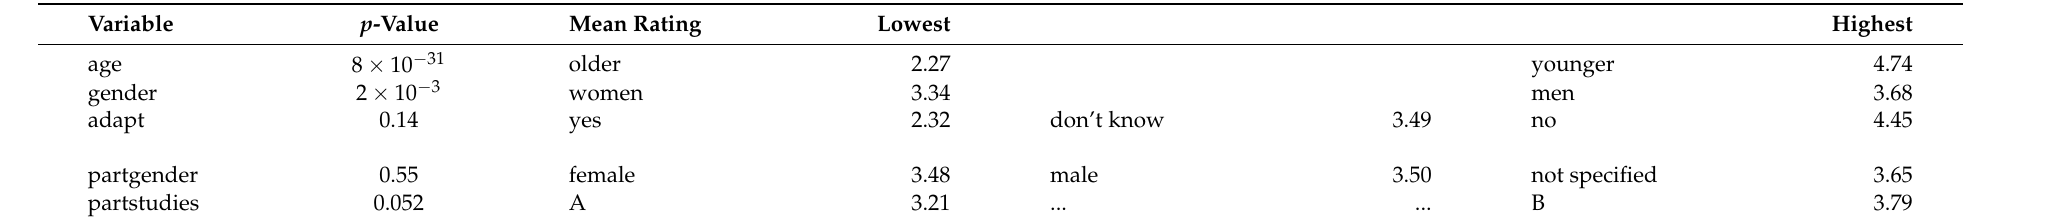
Table A4. Expertise with Desktop computer (PC), p -value from ANOVA with associated mean ratings.